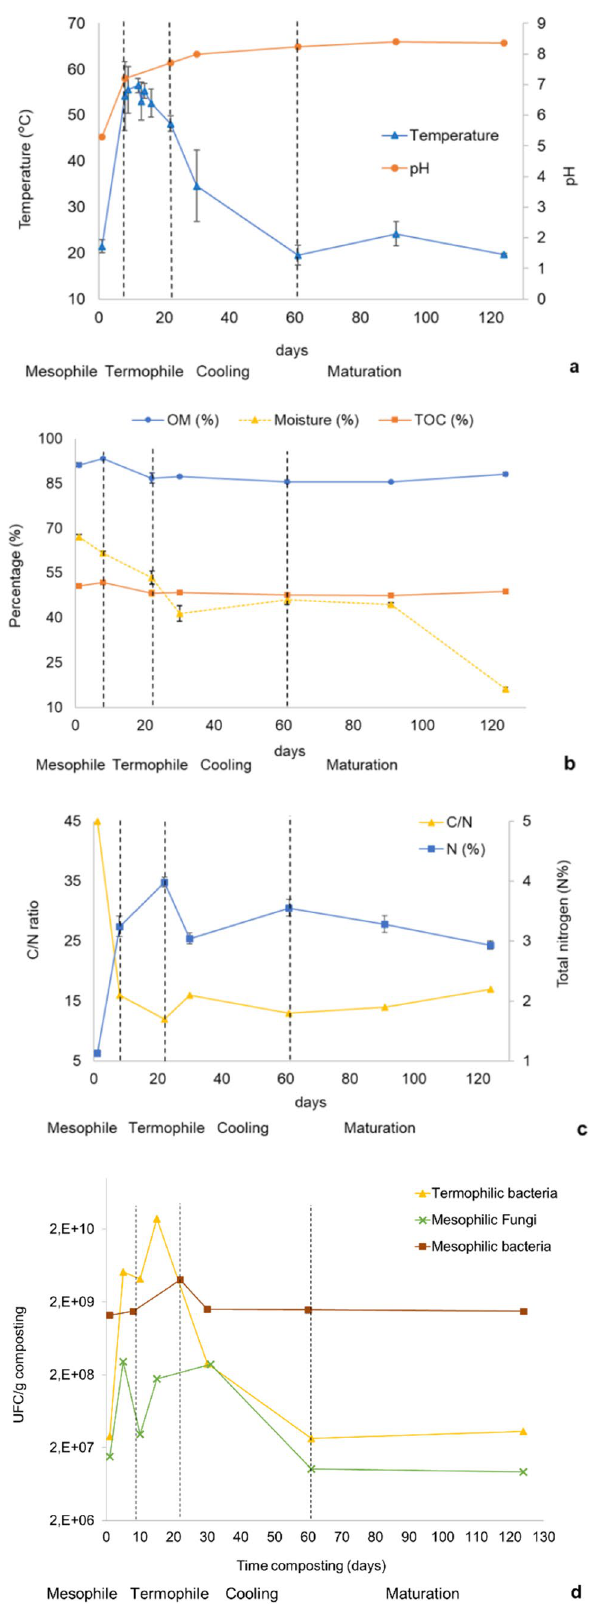
Fig. 1 Physical–chemical and biological characterization of com- posting of rose residues during 124 days. a Evolution of tempera- ture and pH during composting. b Evaluation of total solids content (%TS), organic matter (%OM), moisture (% moisture), total organic carbon (% TOC); c C/N ratio and total nitrogen (%N) during com- posting; d: Counting of (CFU/g) of bacterial and fungal populations during composting